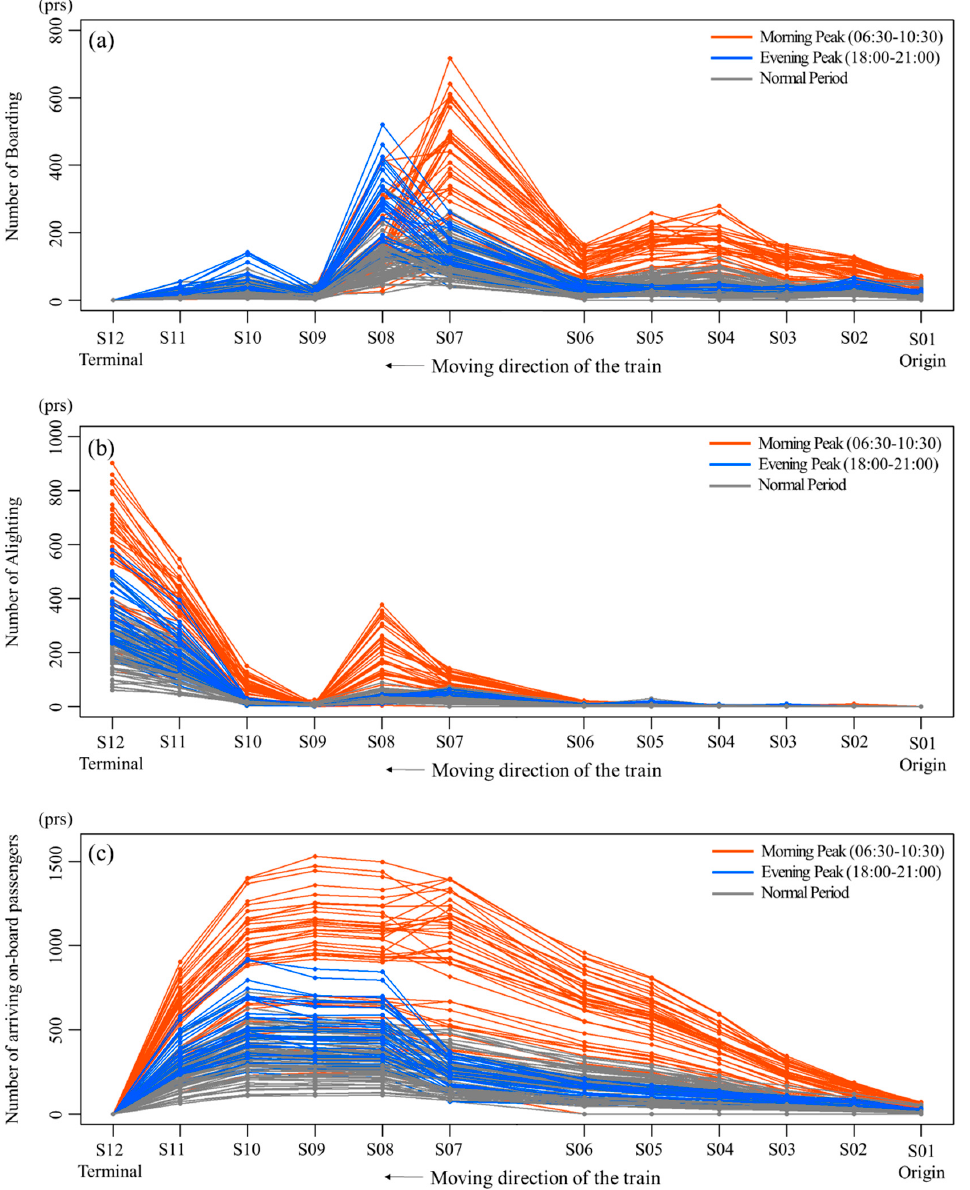
Figure 4. ( a ) The number of boarding passengers at each station. ( b ) The number of alighting passengers at each station. ( c ) The number of onboard passengers when the train had been arrived at each